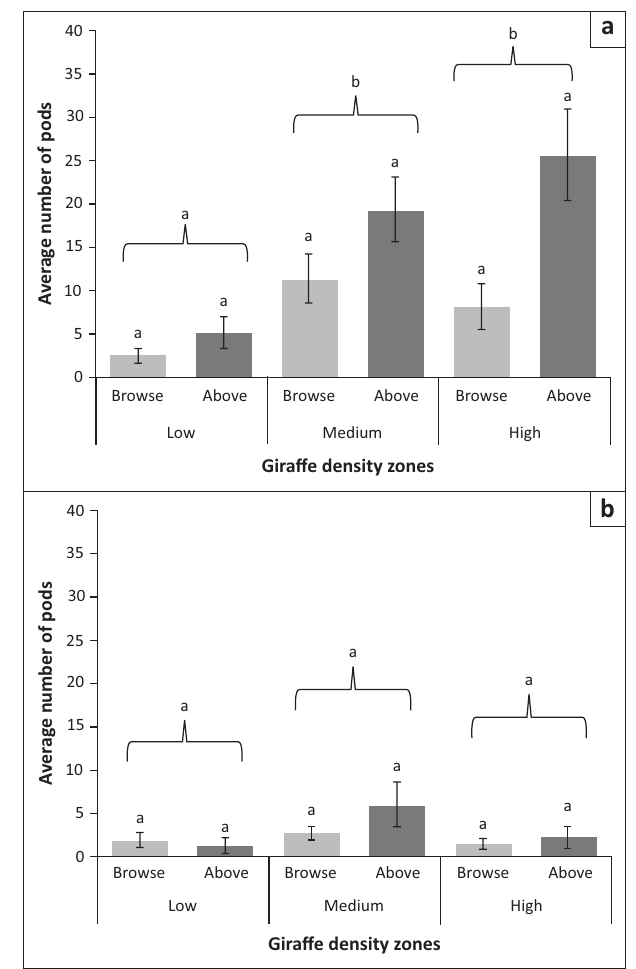
FIGURE 2-A1: Average number of pods (± standard error) for (a) Vachellia erioloba and (b) Vachellia haematoxylon in each of the giraffe density zones (low, medium and